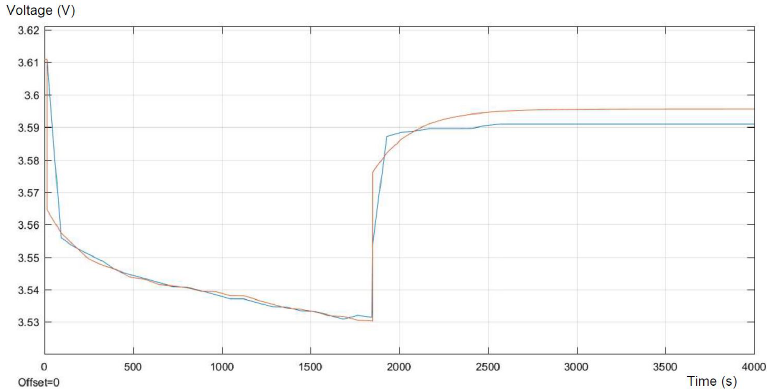
Figure 12. Comparison of the model response and experimental results from the discharge process performed with a 0.1 C-rate. The blue curve is the real pulse discharge process measured on the workstation. The red curve presents the model response in the same